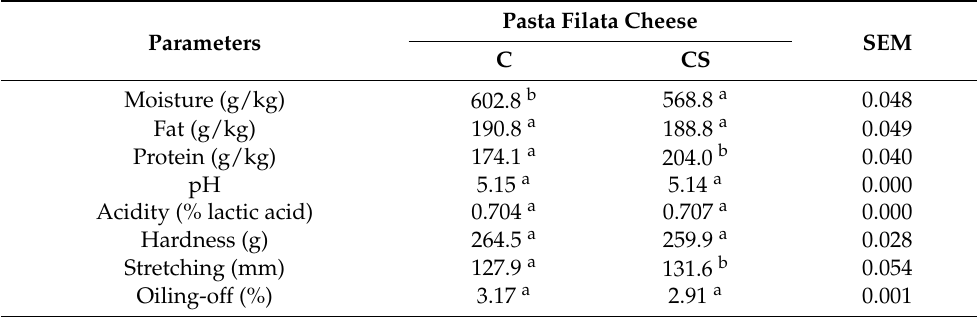
Table 2. Gross composition and physicochemical characteristics of pasta filata cheeses from cow’s milk and a mixture with sheep’s